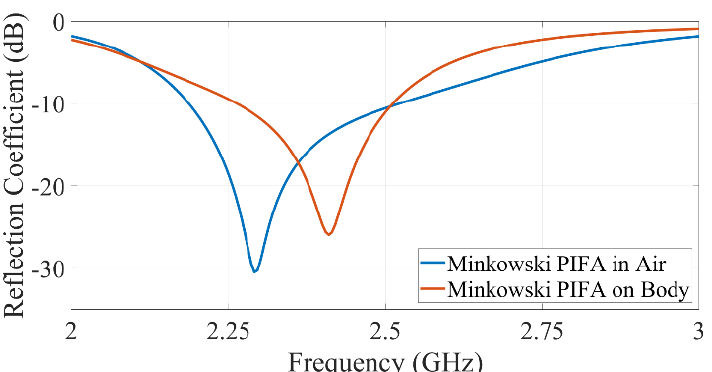
Figure 7. Simulated reflection coefficient for the Minkowski pre-fractal-shaped PIFA in air and placed on the human body. Table 1. Dielectric Properties of Body Tissue.